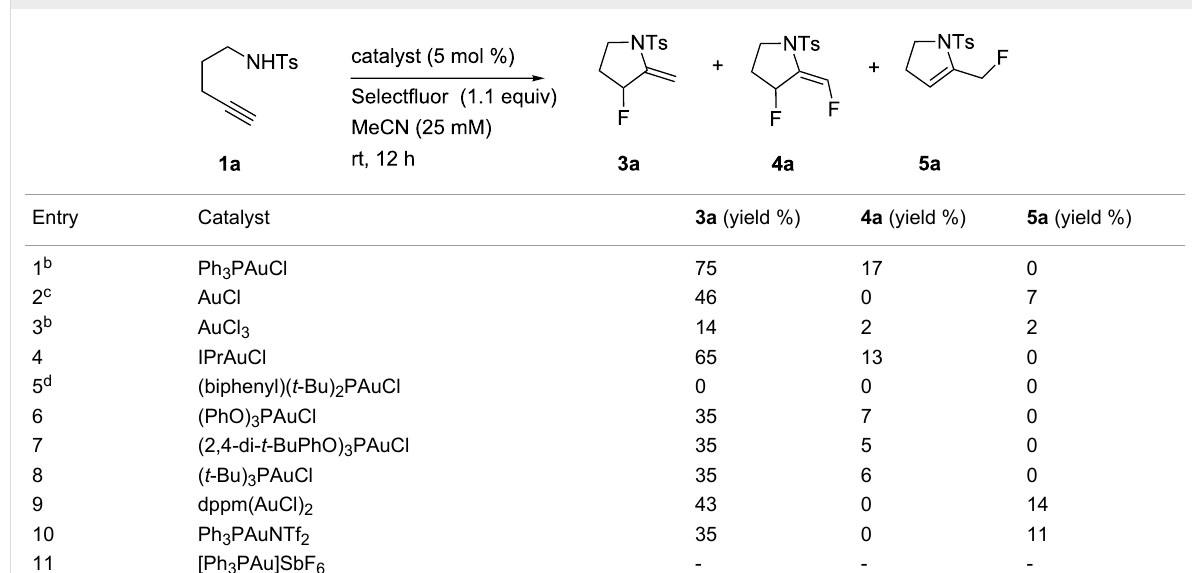
Table 1: Gold catalyst influence on the cyclization of 1a .